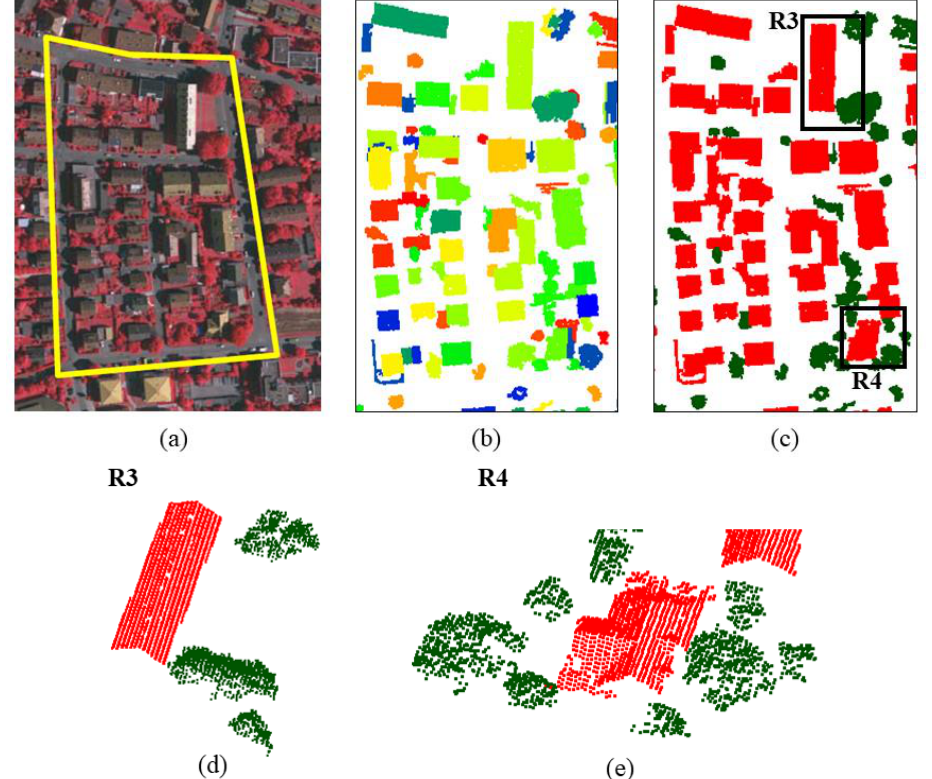
Figure 3. Vaihingen dataset. Infrared aerial image (a), non-ground points after region growing process (b), and identification of building clusters using the proposed method